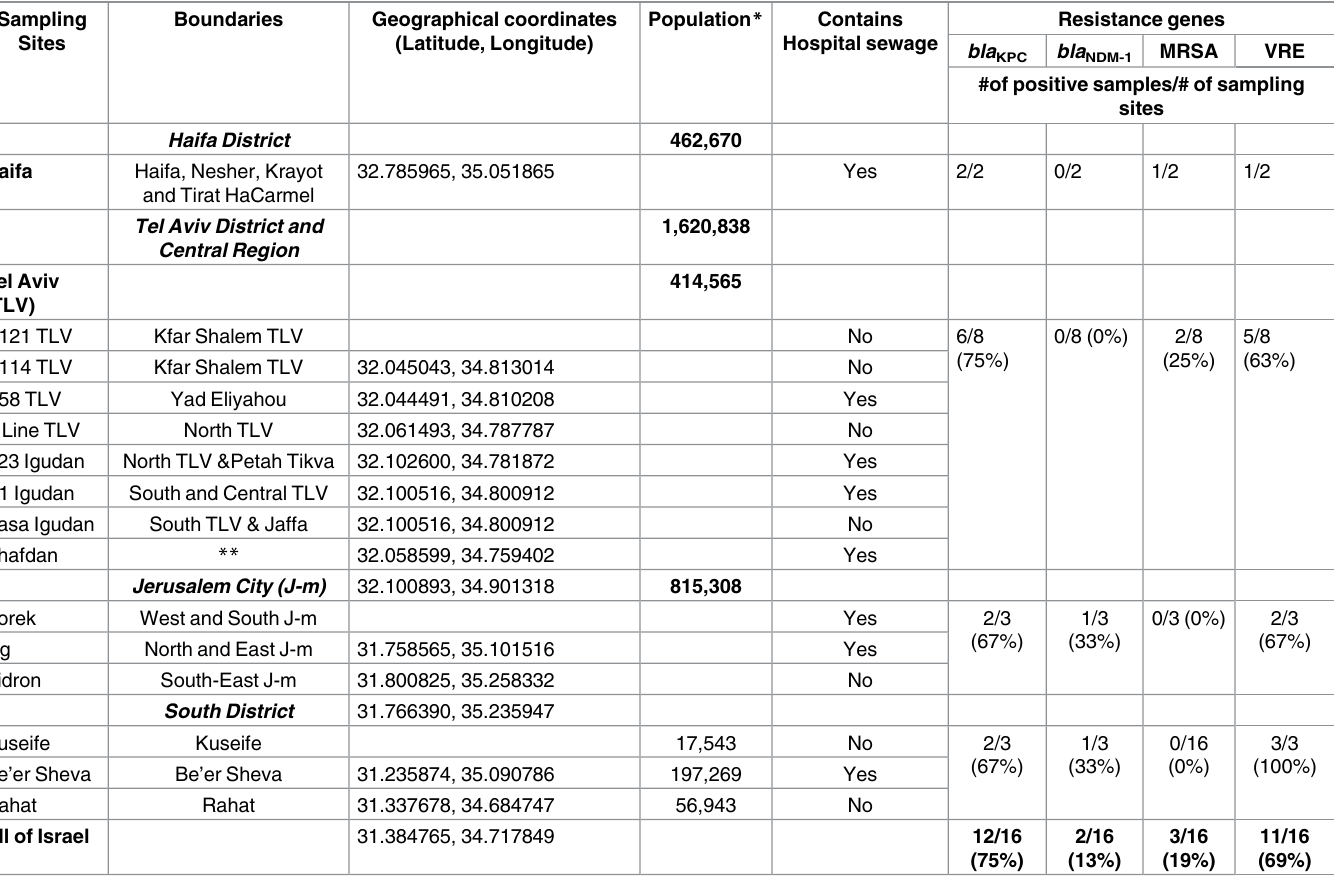
Table 1. Sampling sites